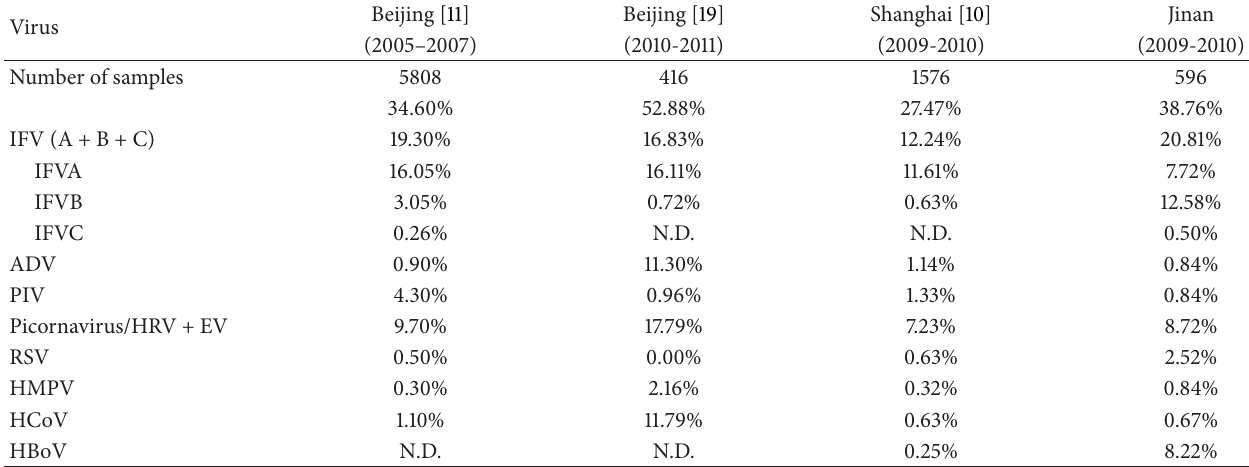
Table 4: Respiratory virus detection rate in adult patients with ARTIs from Beijing, Shanghai, and Jinan.